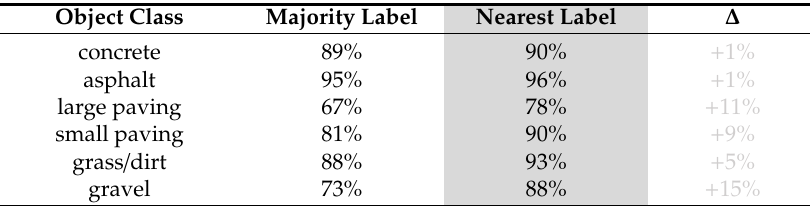
Table 5. Majority point labeling scheme vs. nearest label scheme (mean F1-score).